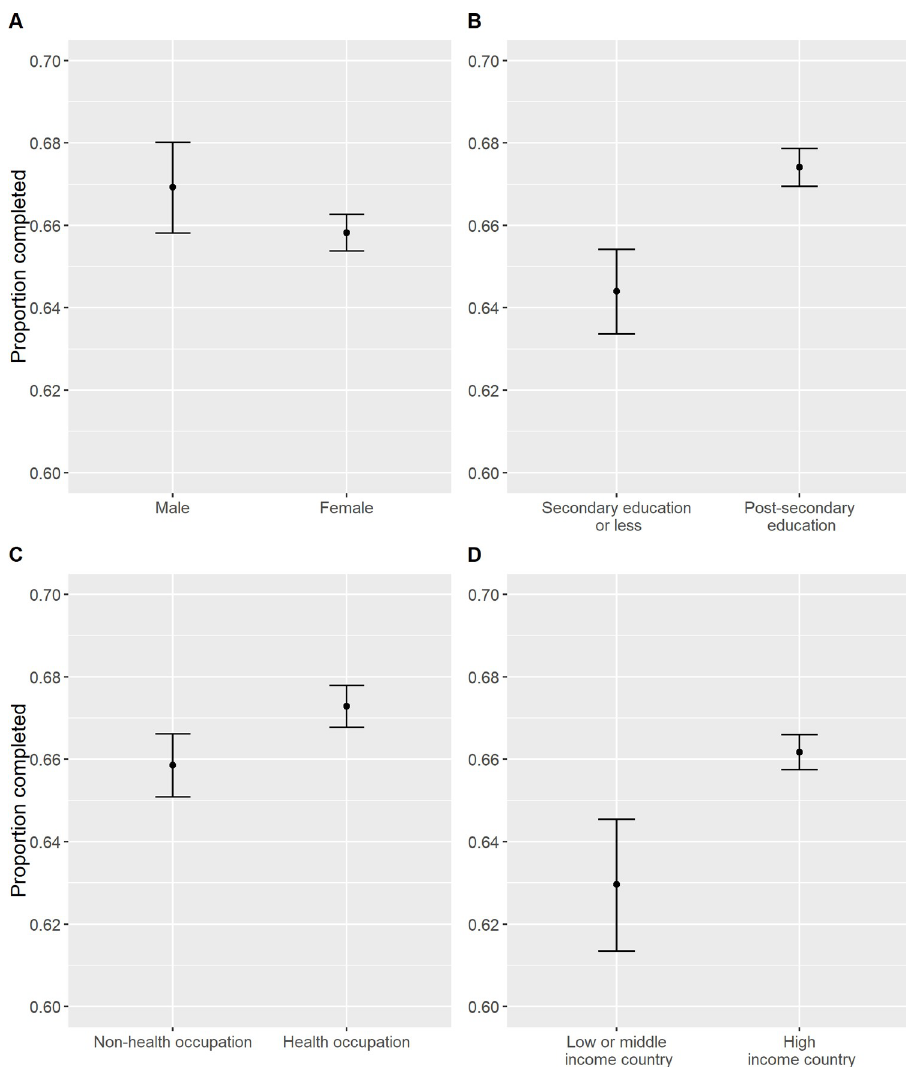
Fig 5. Proportions of participants who completed the Preventing Dementia MOOC by gender (A), highest level of education (B), work in health care and social assistance or other sectors (C), and wealth of country of residence (D) across all seven Preventing Dementia MOOC